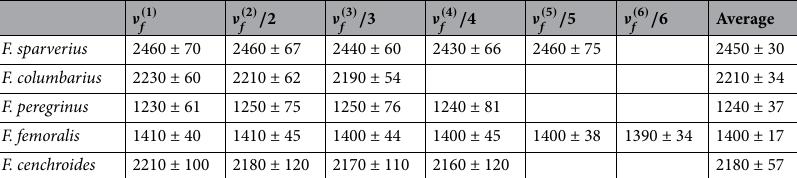
Table 4. Maximum frequencies per harmonic number ν confidence